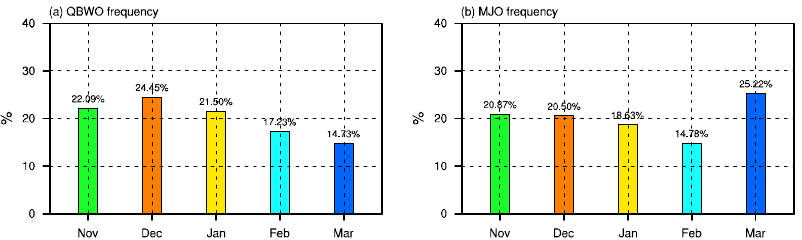
Figure 4. Frequency distribution (unit: %) of ( a ) QBWO days in phases 6–8 and ( b ) MJO days in phases 2–4 for each winter month during 1998–2018.